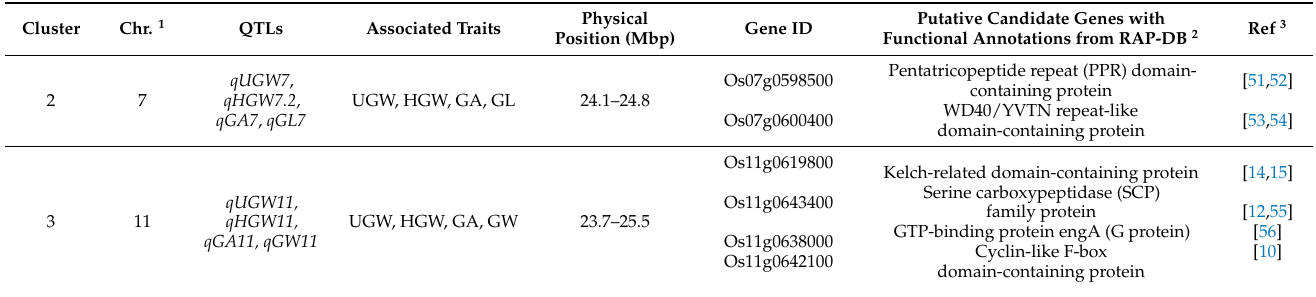
Table 3. Grain size-related QTL clusters and putative candidate genes identified in this